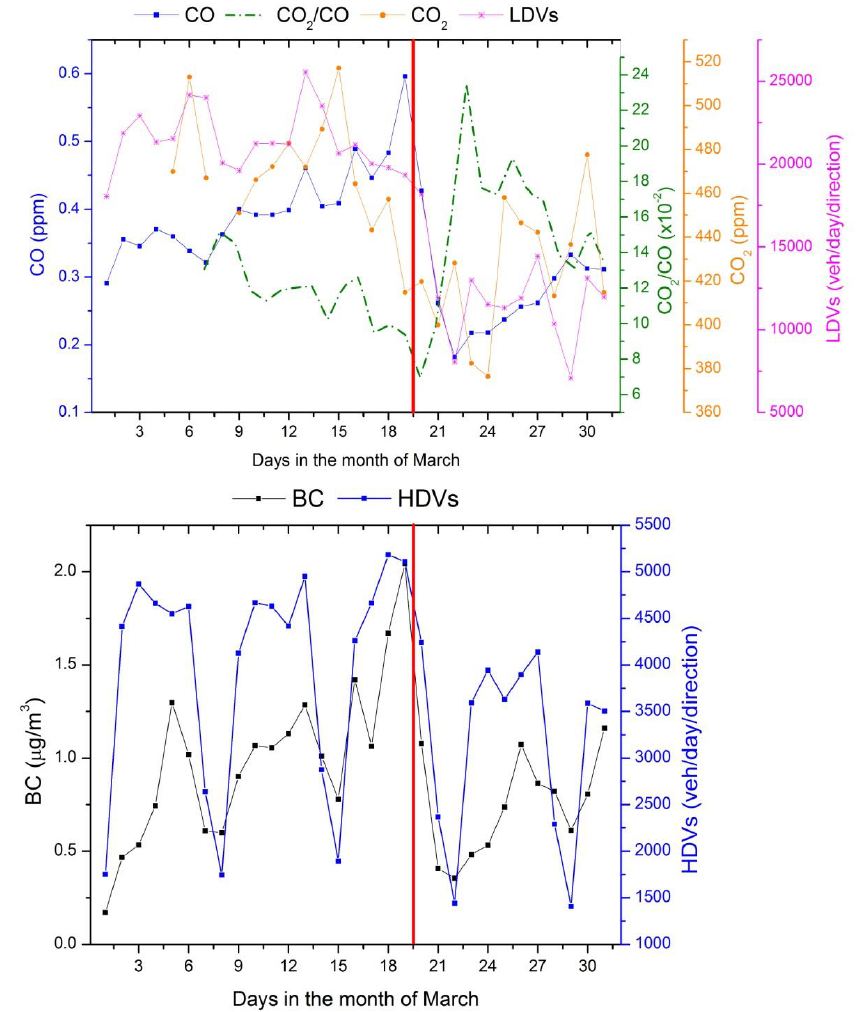
Figure 7. CO, CO 2 and black carbon (BC) concentrations related to traffic volume in São Paulo.